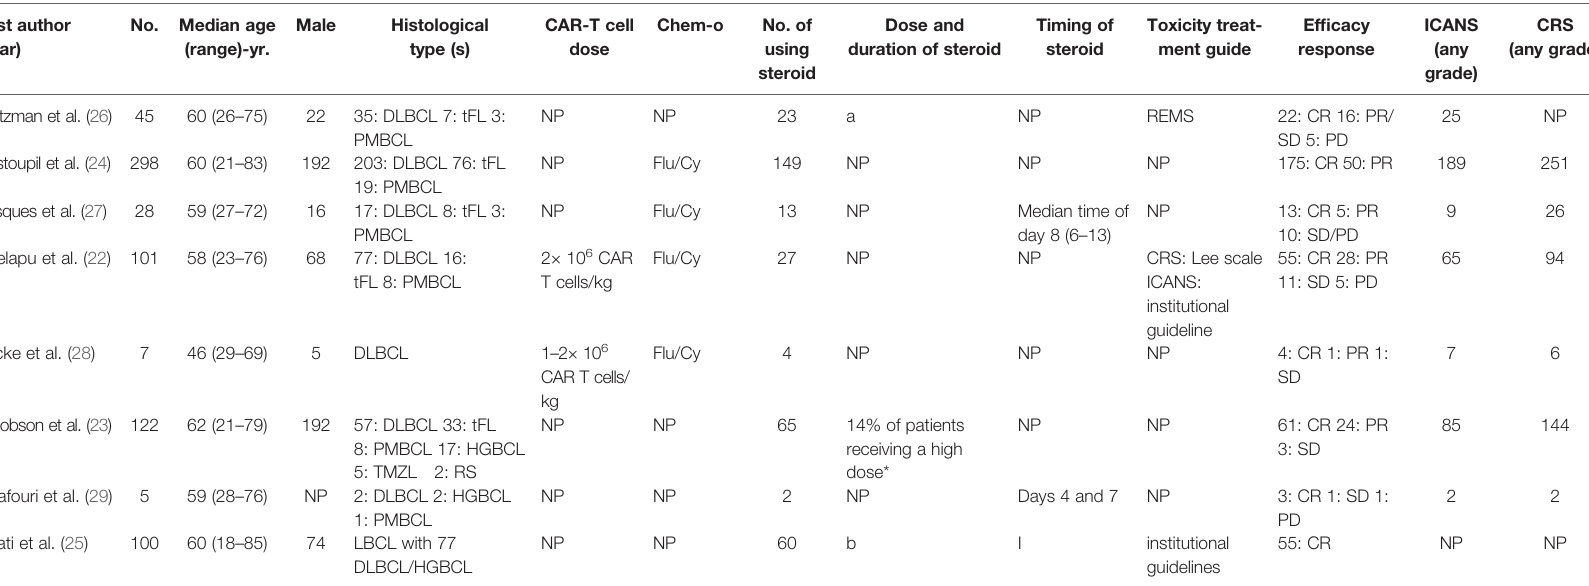
TABLE 1 | The baseline characteristics of the included